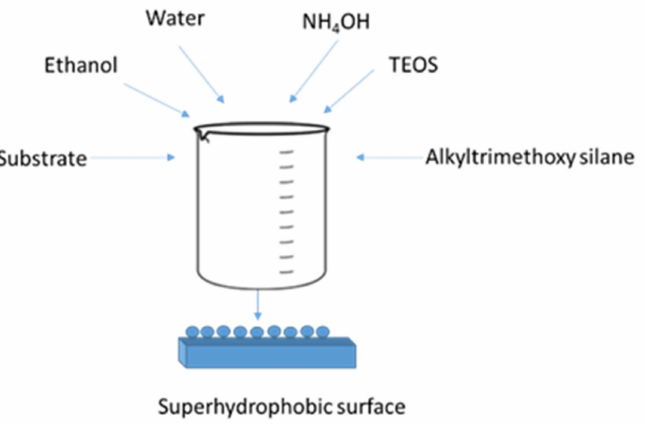
Figure 2. In-Situ superhydrophobic coating preparation. TEOS: tetraethyl orthosilicate.